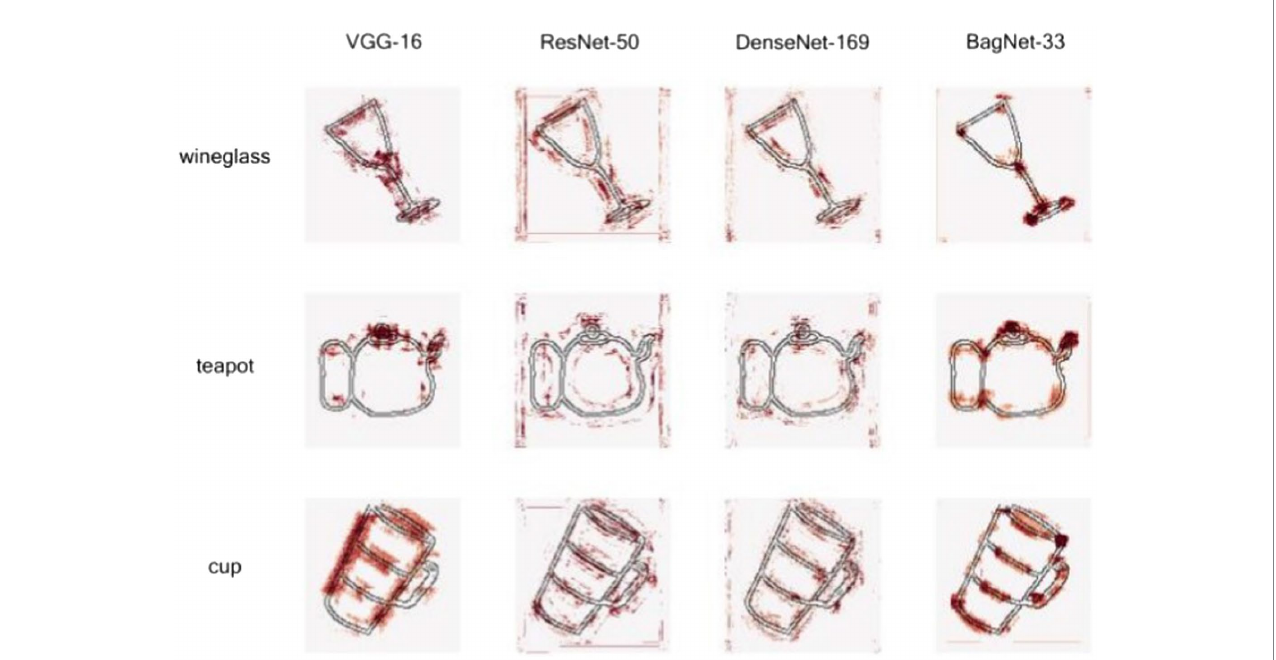
FIGURE 4 CAM of three objects by different models from Theodorus et al. (2020). The more the dots are clustered, the more of the corresponding area is considered in the model. Note that VGG-16 and BagNet-33 learned the representation of object parts. Reprinted with